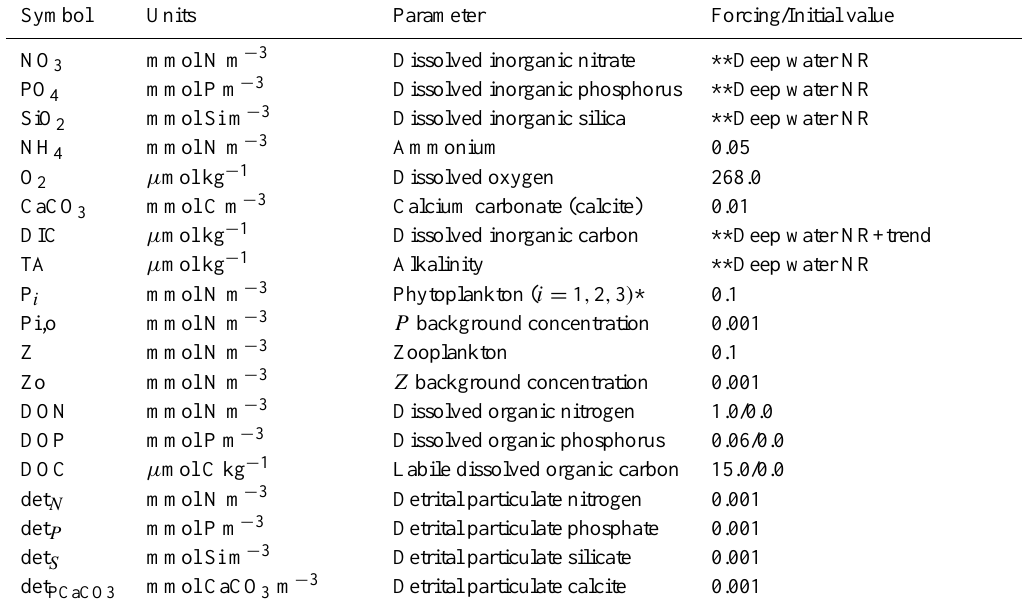
Table B1. Ecosystem/carbon model state variables definition, forcing strategy, and initial values.